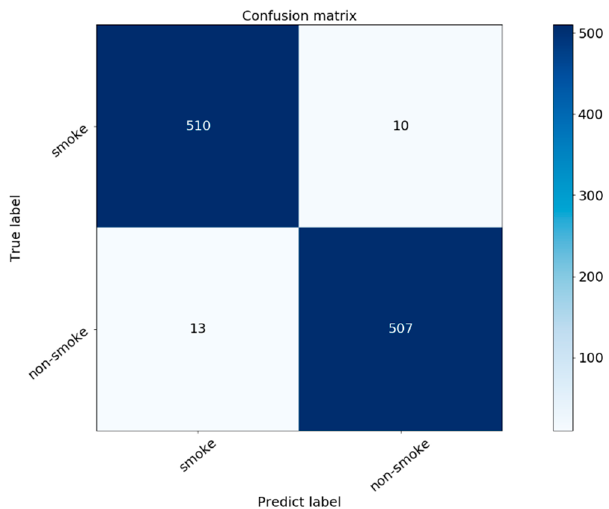
Figure 9. Confusion matrix of the proposed model. In the confusion matrix, the squares at the top left and bottom right indicate the true positive and true negative cases, respectively, and the bottom left and top right indicate the false positive and false negative cases, respectively. Figure 10 shows a partial sample of each of these cases.